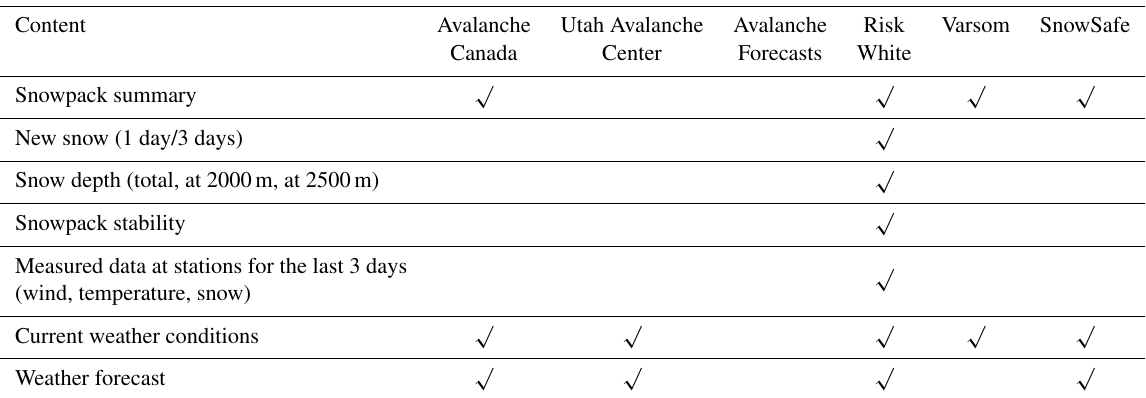
√ indicates that the information is present in the given White